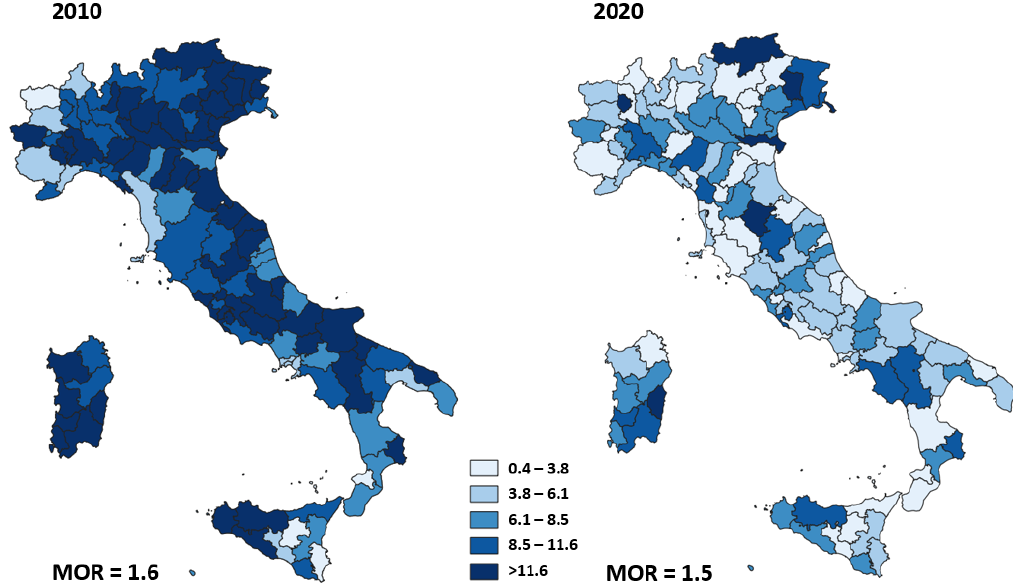
Figure 5. Proportion of reoperation within 90 days of breast-conserving surgery from 2010 to 2020.